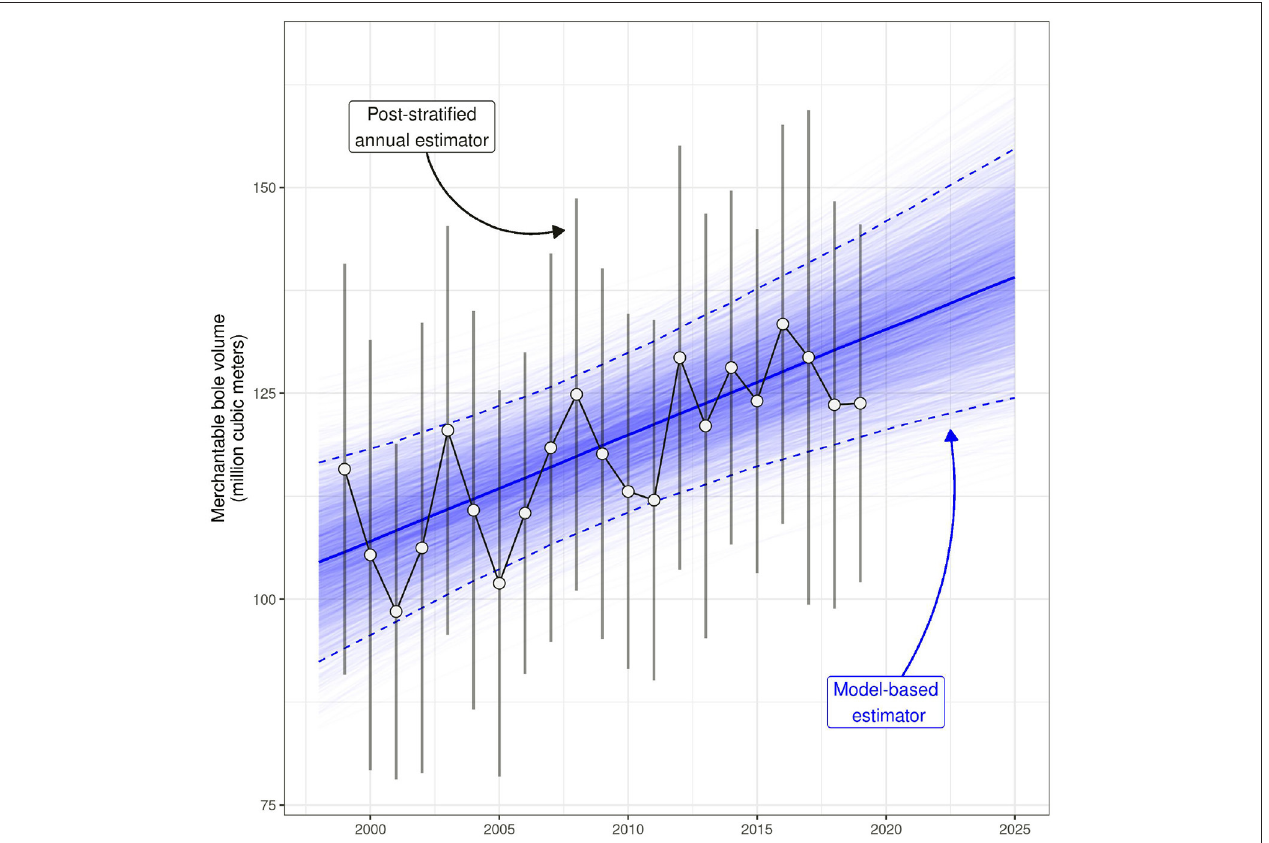
FIGURE 6 | Annual model-based and design-based estimates of total merchantable wood volume (million m 3 ) on timberland in Washington County, Maine. Model-based point estimates are derived from the posterior median of Hamiltonian Monte Carlo (HMC) samples of parameters presented in Equations (14)–(15), and are represented by the solid, dark blue line. Similarly, model-based interval estimates (i.e., Bayesian 95% credible intervals) are derived from the 2.5 to 97.5% quantiles of HMC samples, and are represented by dashed, dark blue lines. Further, realizations of parameters presented in Equations (14)–(15) from each HMC sample are represented as thin, semi-transparent blue lines. Hence the posterior predictive distribution of the model-based estimator of total merchantable wood volume can be inferred from the relative density of thin blue lines in a given region of the graph (i.e., higher density of lines indicates higher posterior probability). Annual, design-based point estimates are represented by white circles, and are connected by a solid black line. Design-based interval estimates (95% confidence intervals) associated with each annual point estimate are presented as vertical gray bars. All design-based estimates were produced using the annual, post-stratified estimation approach implemented in rFIA (Stanke et al.,